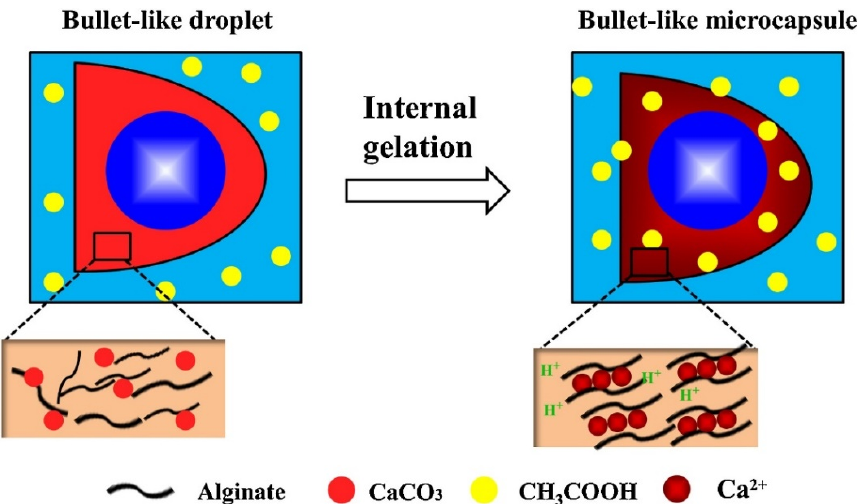
Figure 7. Schematic picture of the Ca-alginate core-shell microcapsule formation by means of internal gelation in monodisperse double emulsions. Oil/Water/Oil droplet templates were obtained via a dual-coaxial capillary microfluidic device. O/W/O droplets were produced at the second stage by the shearing force of the outer oil phase. Image reproduced from Huang, L. et al., with permission from Colloids Surf. A Physicochem. Eng. Asp.